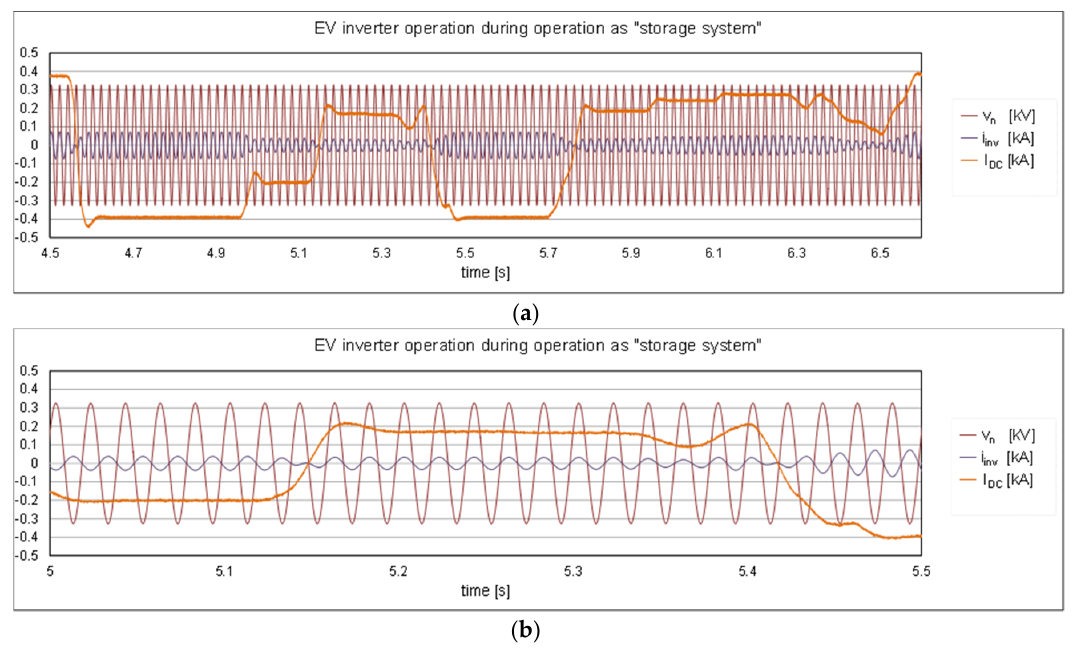
Figure 5. ( a ) EV operates as energy storage system in normal network state. ( b ) The zoom of the upper Figure 5. (a) EV operates as energy storage system in normal network state. (b) The zoom of the upper Energies 2020 , 13 , x FOR PEER REVIEW diagram, period (5–5.5) s. diagram, period (5–5.5)s.